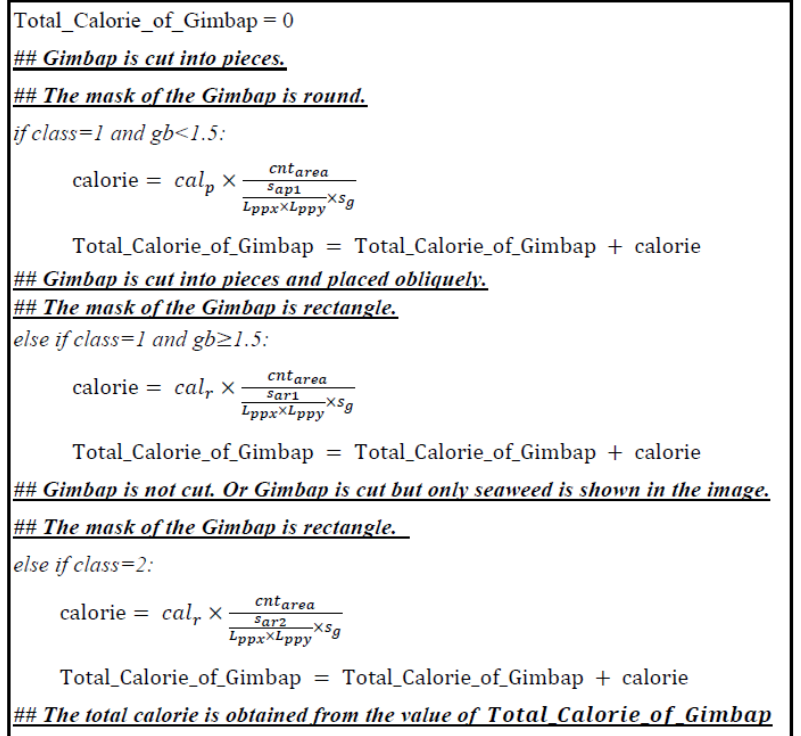
Figure 7. The pseudo-code to estimate Gimbap calorie, where s ap 1 , s ar 1 and s ar 2 are the surface area of the labeled Gimbap. L ppx and L ppy are the physical sizes corresponding to each pixel on the x and y axes, based on calibration process. s g is a constant scale